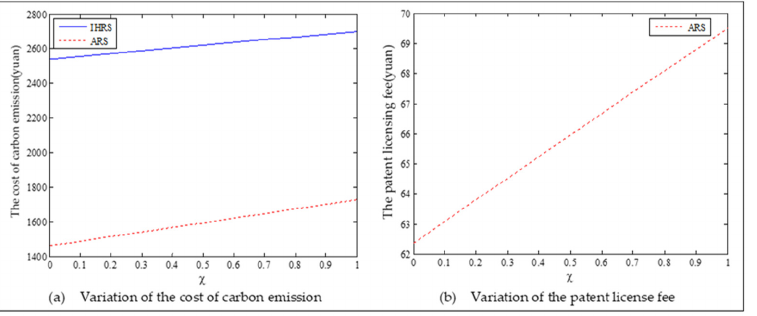
Figure 13. Changes of the costs of carbon emission and the patent licensing fee in Case 1 of Section 6.2.